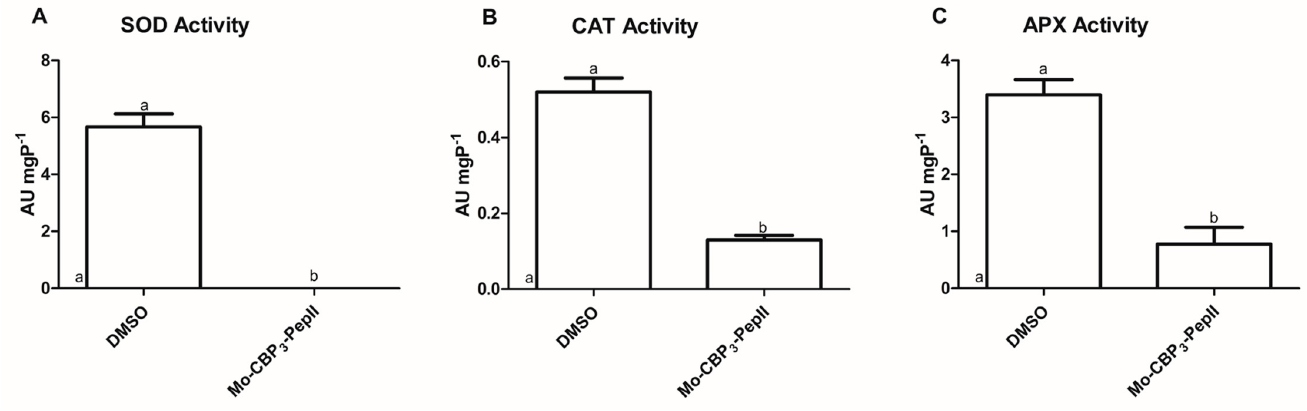
Figure 2. The activity of enzymes involved in ROS in C. neoformans cells after treatment with Mo - CBP 3 -PepII. ( A ) SOD activity that converts •O 2 − into H 2 O 2 , ( B ) CAT activity that converts H 2 O 2 into H 2 O in O 2 , and ( C ) APX activity that converts H 2 O 2 into H 2 O in O 2 using ascorbate as electron donor. The activity of enzymes was tested in C. neoformans cells treated ( Mo -CBP 3 -PepII) and non-treated (DMSO) with the synthetic peptide. The different lowercase letters indicate statistical significance at p > 0.05.